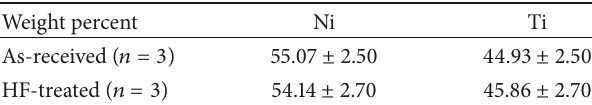
Table 2: Ni and Ti composition in as-received and HF-treated samples in K3